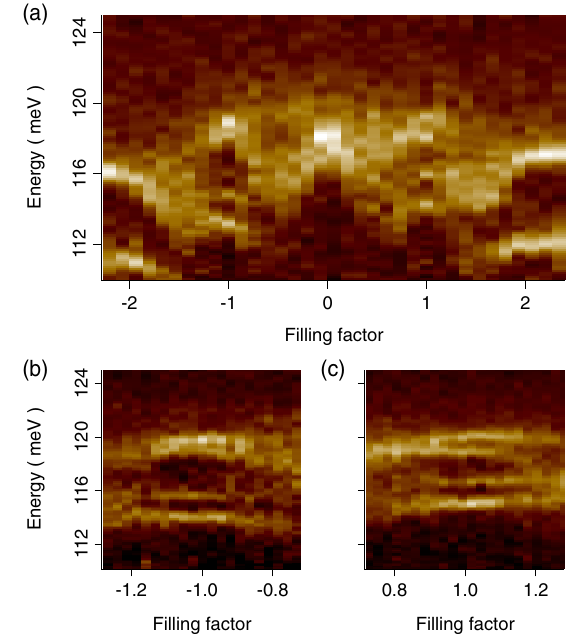
FIG. 4. Particle-hole asymmetry. (a) Close-up of T 1 transition from Fig. 1(a), showing a clear asymmetry for positive vs negative filling factors. (b,c) Higher-resolution (finer abscissa spacing) maps at ν ¼ − 1 and þ 1 , respectively, revealing particle- hole symmetry breaking in the fourfold splittings.